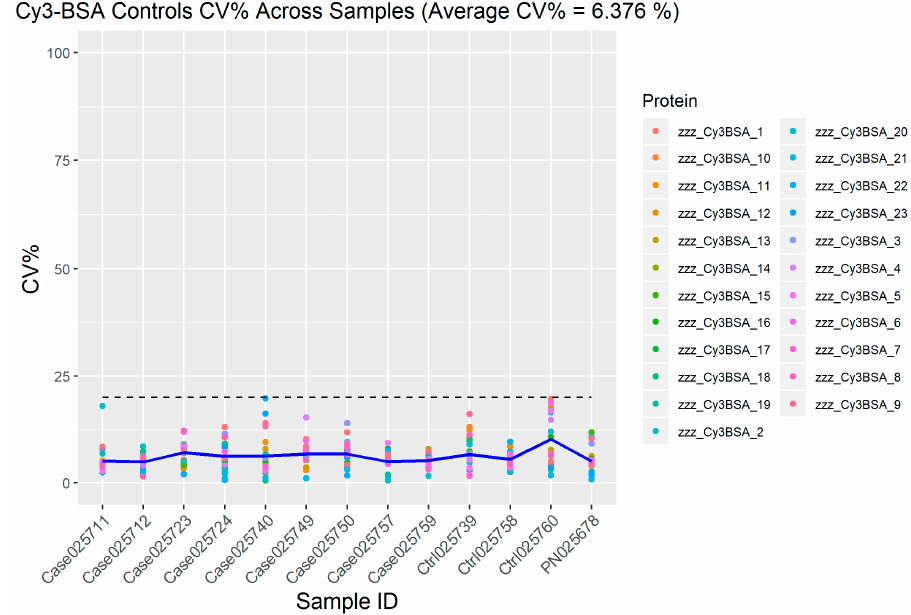
Figure 4. Sengenics-Immunome ™ Protein Array replica images for all replicas of Cy3BSA control spots showing consistency in the intensities.